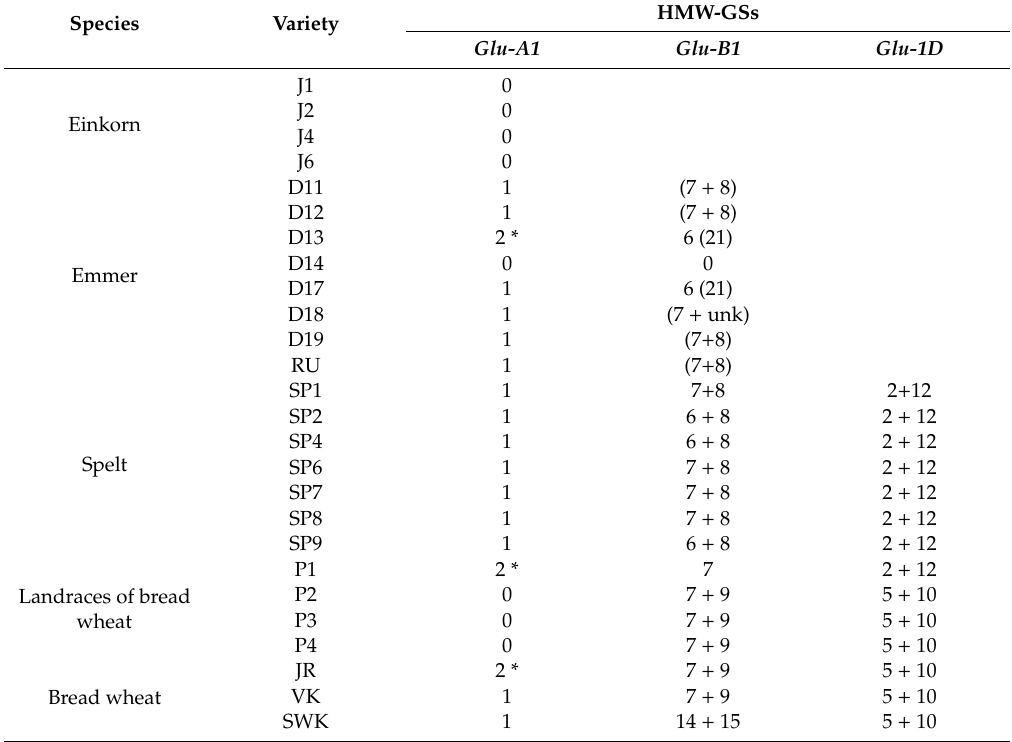
Table 1. Allelic frequency for Glu-A1, Glu-B1, and Glu-D1 loci of the evaluated varieties. Species Variety